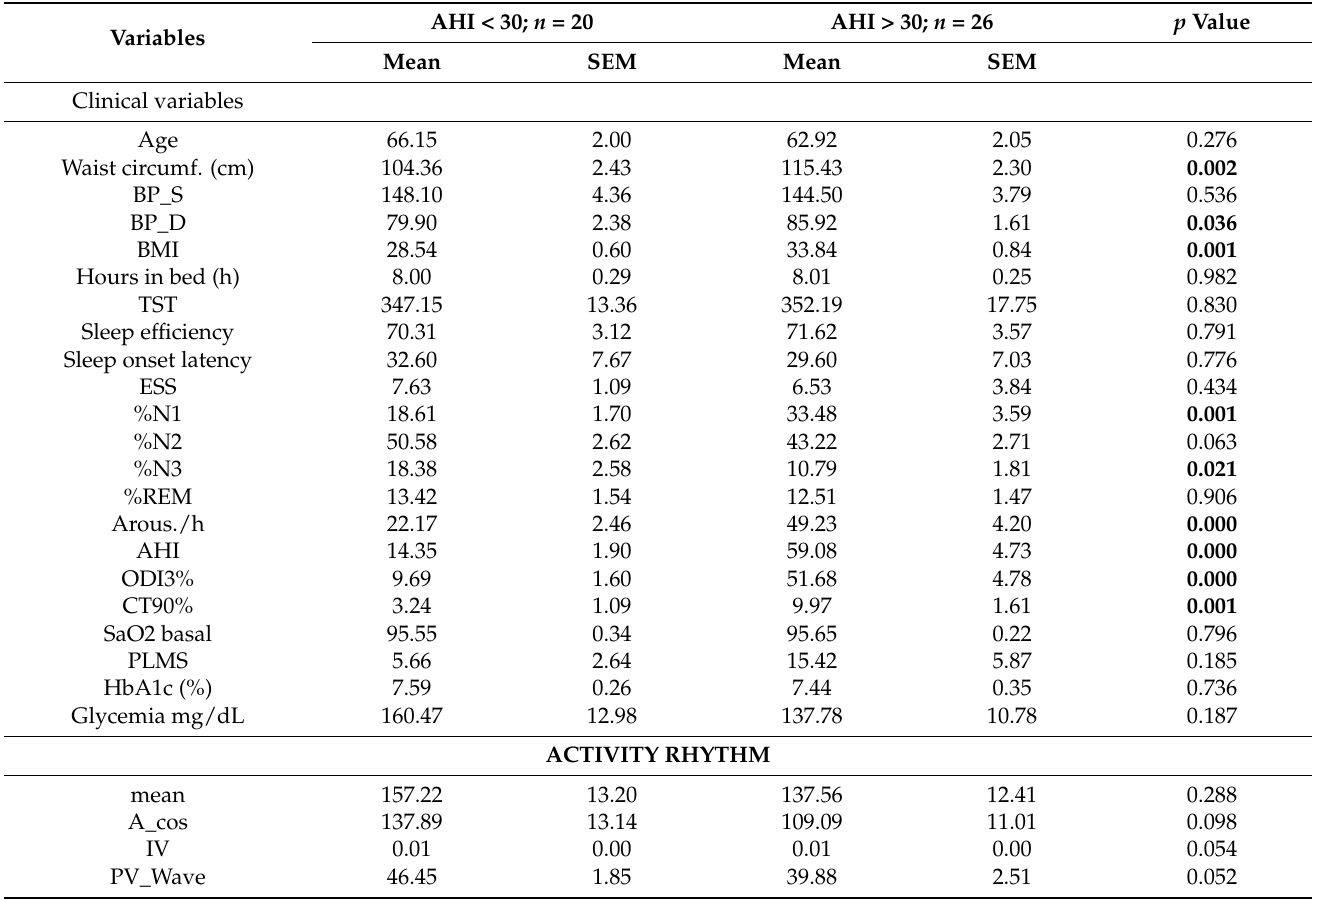
Table 1. Demographic, clinical, polysomnographic and circadian variables of the participants (patients with type 2 diabetes) stratified in two groups according to the level of apnea-hypopnea index (AHI) (SEM: standard error). p indicates the significance obtained by Student’s t test. Significant differences are indicated in